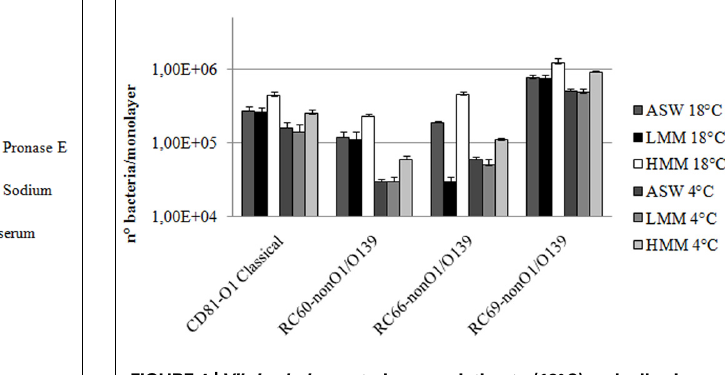
FIGURE 4 | Vibrio cholerae strains association to (18 ◦ C) and adhesion with (4 ◦ C) hemocyte monolayers in the presence of hemolymph serum LMM and HMM fractions. P <